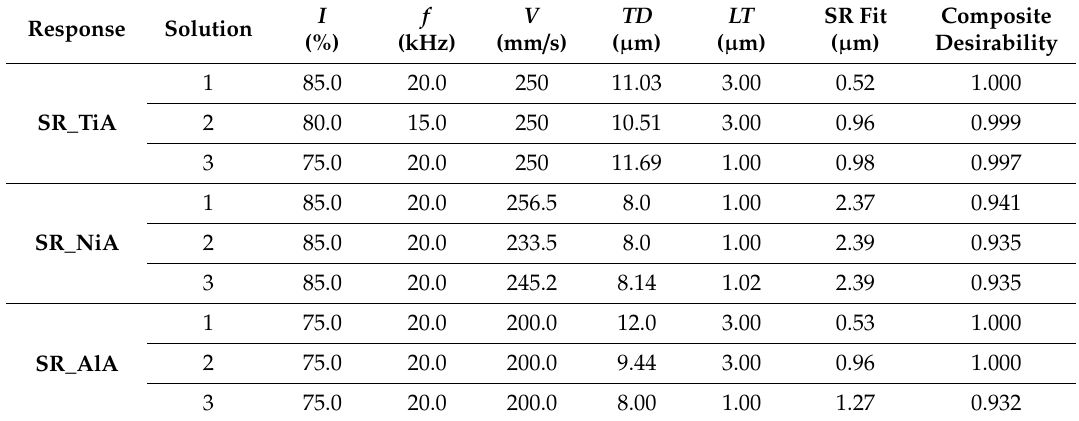
Table 8. Multiple response prediction solutions for TiA, NiA, and